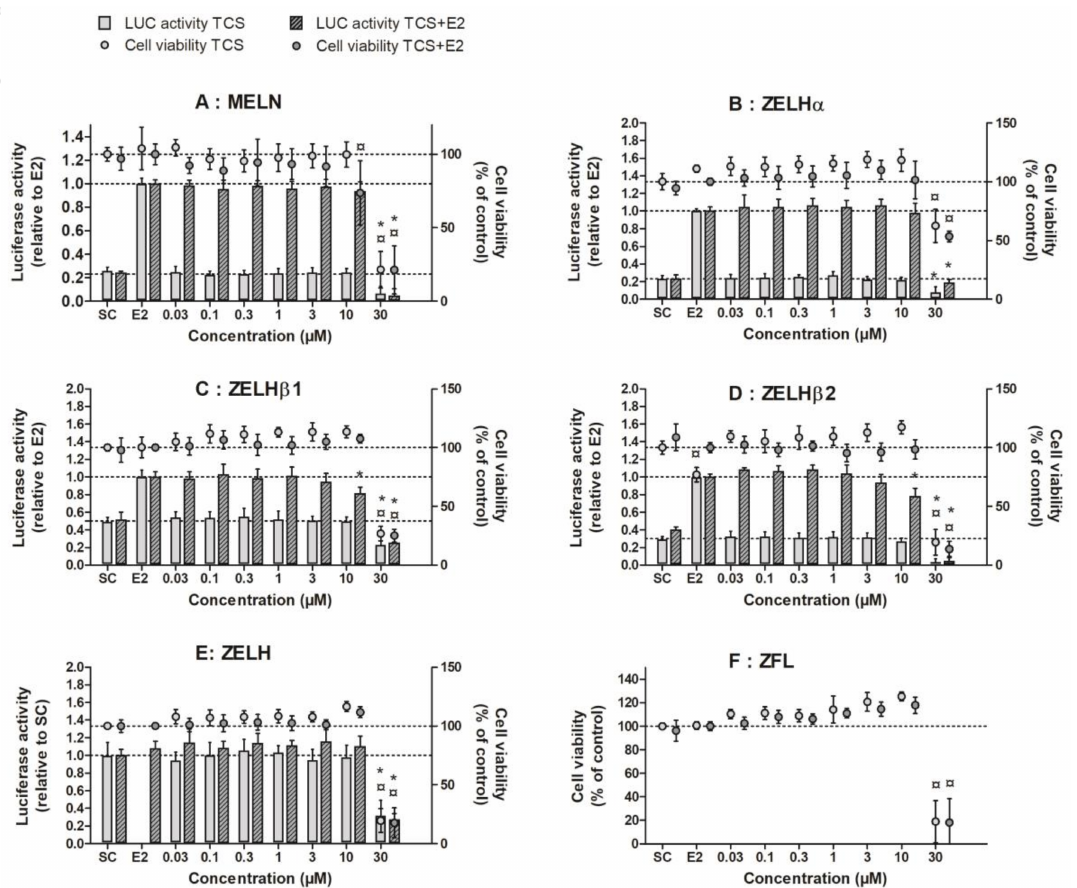
Figure 2. Luciferase response (LUC, bars) and cell viability (circles) of MELN ( A ), ZELH α (B ), ZELH β 1 ( C ), ZELH β 2 ( D ), ZELH ( E ) and ZFL ( F ) cells after exposure to TCS (0.03 to 30 µ M) for 24 h (MELN) or 72 h (ZELH-zfERs), in presence (dark symbols) or absence (light symbols) of E2. MELN, ZELH β 1 and ZELH β 2 cells were co-exposed to TCS + E2 0.1 nM, and ZELH α , ZELH and ZFL cells to TCS + E2 1 nM. Data represent the mean (+/ − SD) of a minimum of 3 independent experiments using technical triplicates. Data were normalized to E2 positive control for luciferase activity. SC: solvent control response significantly different from control cell viability *: response significantly different from control luciferase activity (Mann-Whitney, p <